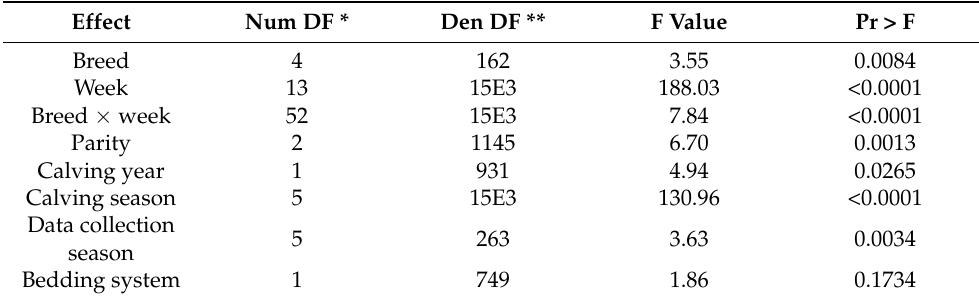
Table A12. Variance analysis results for the variable protein (%).